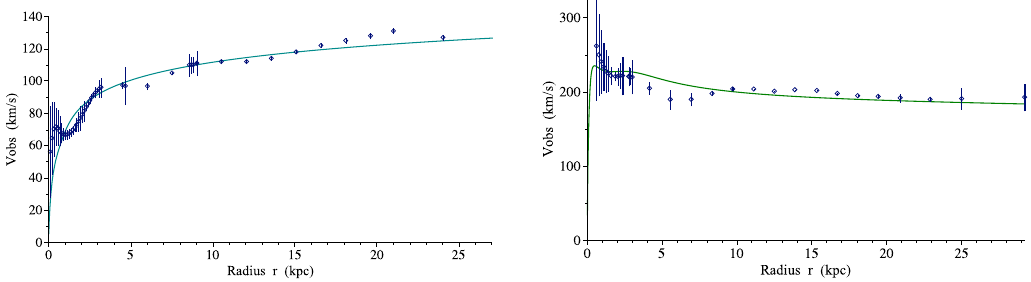
Figure 10. From left to right : UGC03580—Type SAa, SBbulge ( r ) ≠ 0, ( α , β ) = ( 1.8598,3.7529 ) .